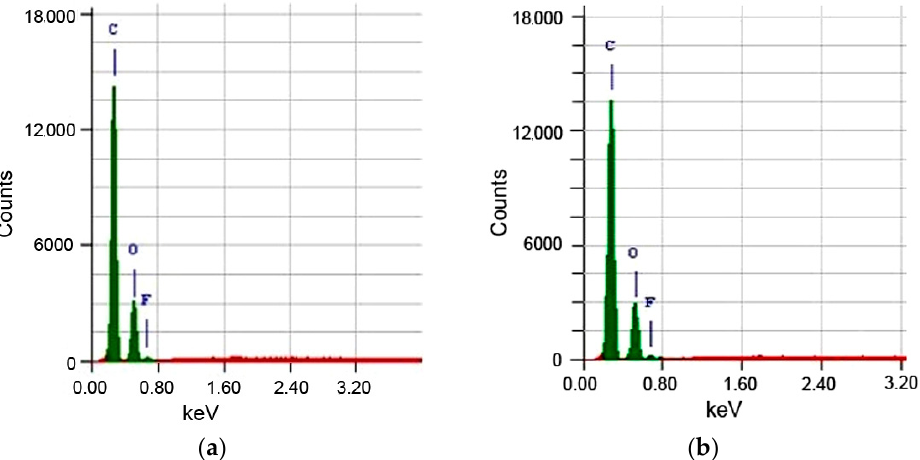
Figure 3. Energy-dispersive analysis of the polyester fabric samples:( a ) processed with a UPTFE FORUM ® solution in SC-CO 2 (the content of the elements: C—63.21%; O—35.63%; F—1.15%); ( b ) after a three-time deposition of a 1.5% solution of TFE/AC telomers (the content of the elements: C—63.75%; O—34.86%; F—1.39%).